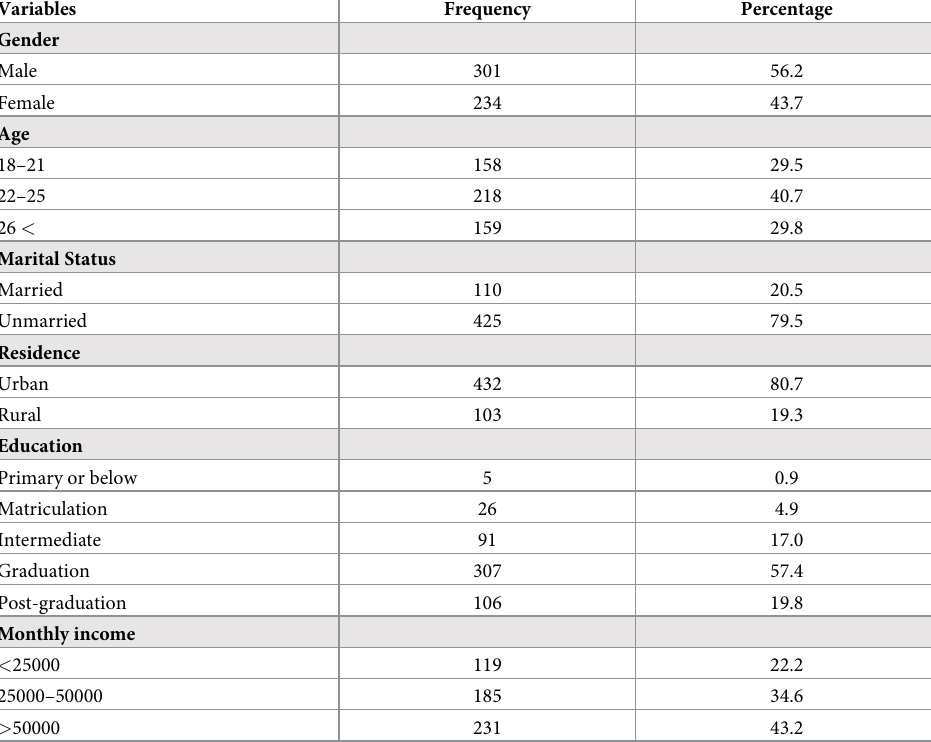
Table 2. Socio-demographic of participants, who had heard about CCHF ( N = 535).